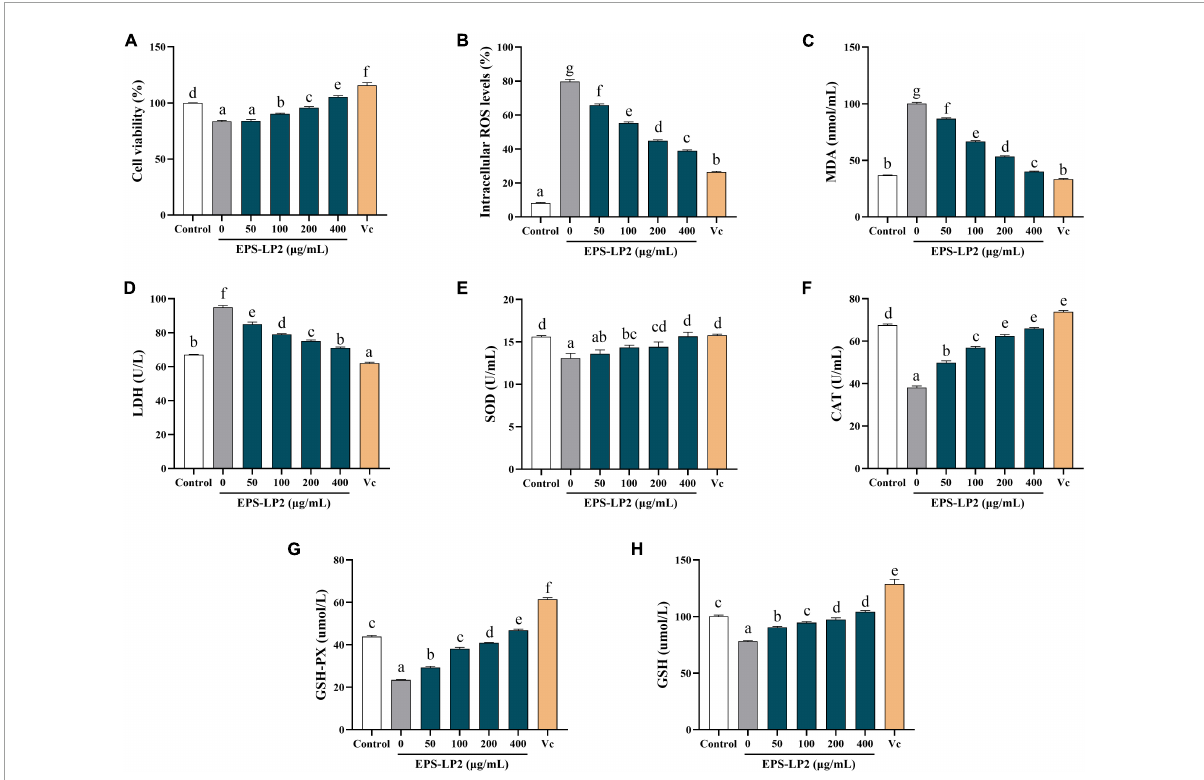
FIGURE4 Effects of exopolysaccharides (EPS)-LP2 on (A) cell viability, the levels of (B) reactive oxygen species (ROS), (C) malondialdehyde (MDA), (D) lactate dehydrogenase (LDH), (E) superoxide dismutase (SOD), (F) catalase (CAT), (G) glutathione peroxidase (GSH-Px), and (H) GSH in RAW264.7 cells induced by H2O2. Different letters represent different significance from the control group ( p <